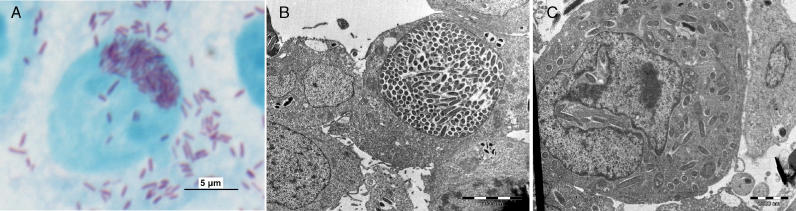

R. bellii Grown in XTC-2 Cell Line(A) Gimenez-stained bacteria observed by optic microscopy.(B) Electronic microscopy of infected cells evidences multiplication of R. bellii within the nucleus. (A) and (B) show the intranuclear accumulation of R. bellii.
(C) Higher-magnification image showing the intrusion of R. bellii into the nucleus.